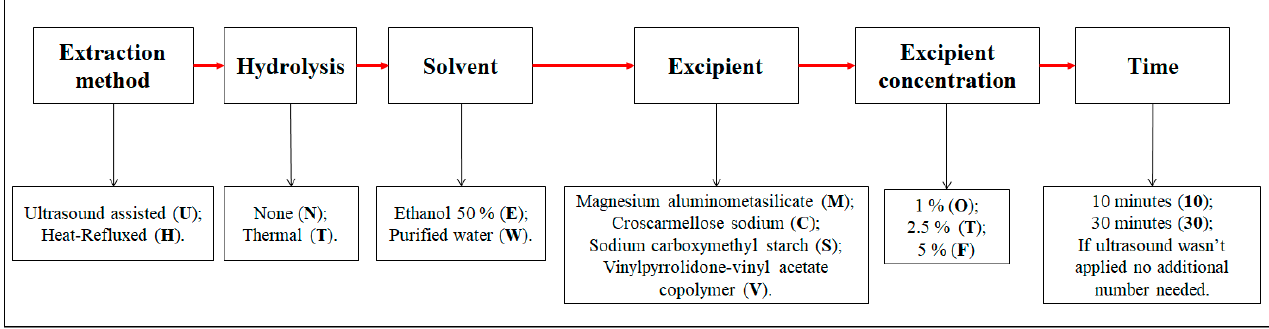
Figure 3. Decoding of the samples provided in Table 2. Extraction conditions using excipients for the experiment.